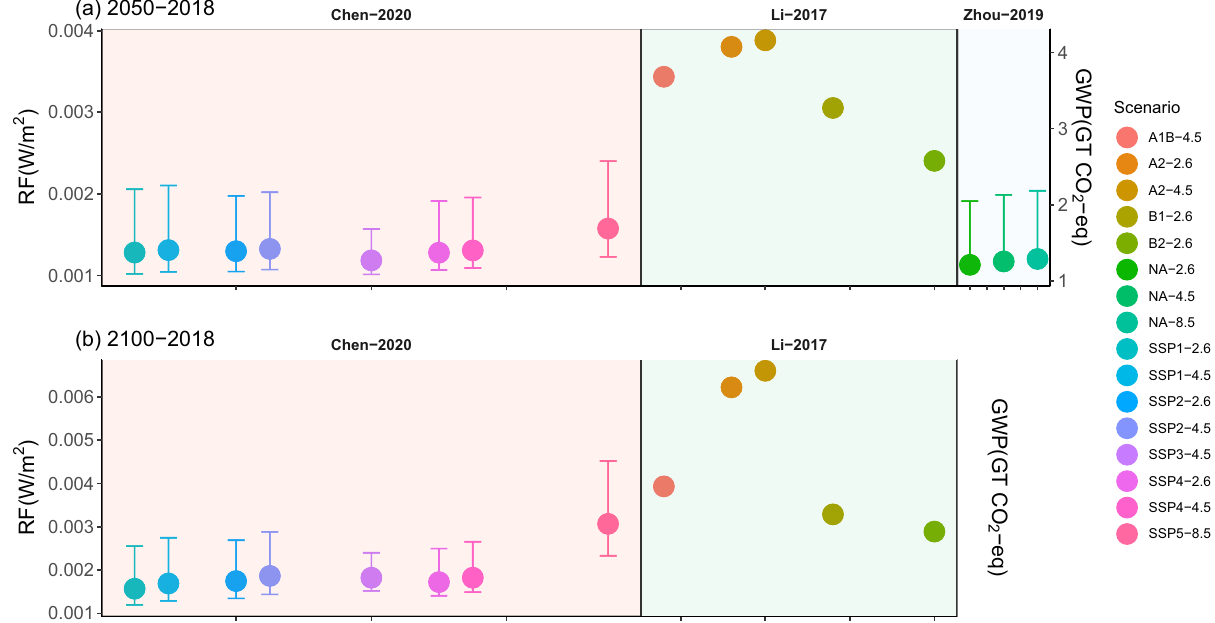
Fig. 5 Comparisons of radiative forcing among using different products of urban land projections. Comparisons of albedo-induced radiative forcing (RF, W/m 2 ) and global warming potentials (GWP, Gt CO2-eq) due to urbanization using different products of high-resolution (1-km) urban land projections a in 2050 relative to 2018 and b in 2100 relative to 2018. The compatibility between SSPs (Chen-2020) and RCPs was adopted from Riahi et al. 53 , and the compatibility between SRES (Li-2017) and RCPs was determined based on the limits of global warming (for example, B1 matches RCP2.6 since the global warming limits of B1 is 1.1 – 2.9 °C). “ NA ” was used for the urbanization scenario in Zhou-2019 as this product follows no scenario families. Error bars shows 90% con fi dence